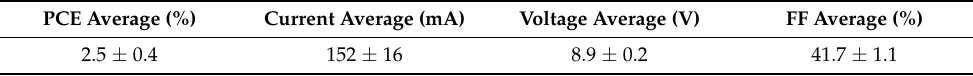
Figure 5. Distribution of electrical parameters of 40 modules made for the Aquaponic Easy Farm project. Clockwise: PCE, I SC , V OC and F. Table 1. Average values and standard deviation of the electrical parameters of the 40 modules.